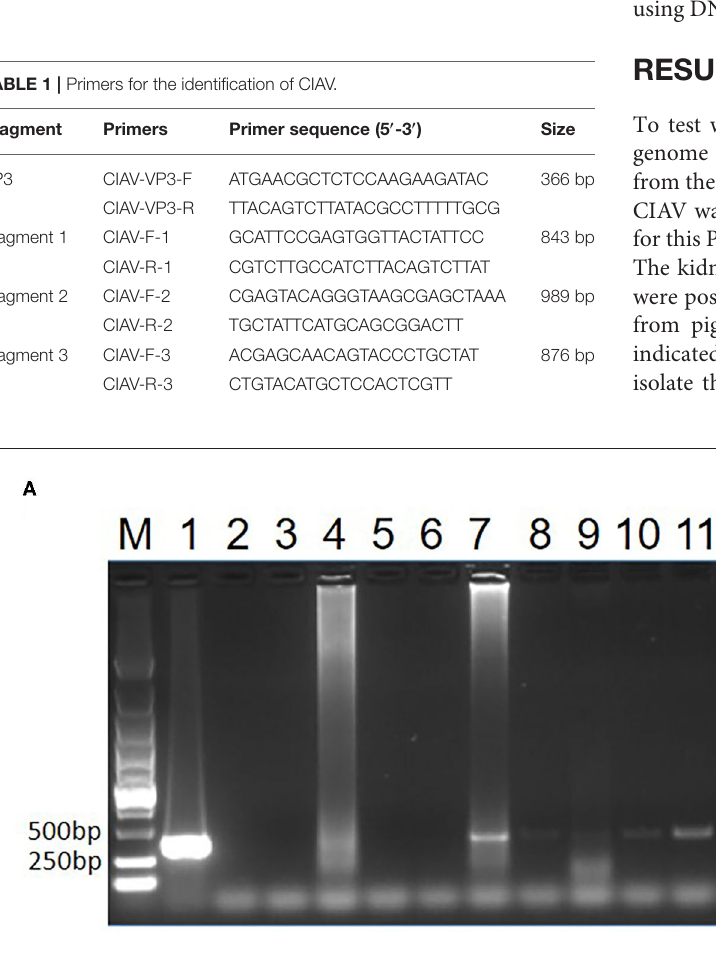
FIGURE 1 | PCR identification of CIAV. PCR detection of CIAV for clinical samples (A) . The genome DNA extracted from the two sick pigeons was tested by PCR using primers specific to CIAV. Lane M was a DNA marker; Lane 1 was CIAV positive control; Lane 2 was the negative control, Lane 3, 4, 5, 6, and 7 were the heart, liver, spleen, lung and kidney from pigeon No. 1, respectively; Lane 8, 9, 10, 11, and 12 were the heart, liver, spleen, lung, and kidney from pigeon No. 2, respectively. Whole genome amplification of Pigeon-CIAV-1906 (B) . The whole-genome DNA of Pigeon-CIAV-1906 extracted from the supernatant of the infected MSB1 cells was amplified by PCR using primers listed in Table 1 . Lane M was the DNA marker; Lane 1, 2, and 3 were the amplified PCR fragment using primers CIAV-F-1/R1, CIAV-F-2/R2, and CIAV-F-3/R3,